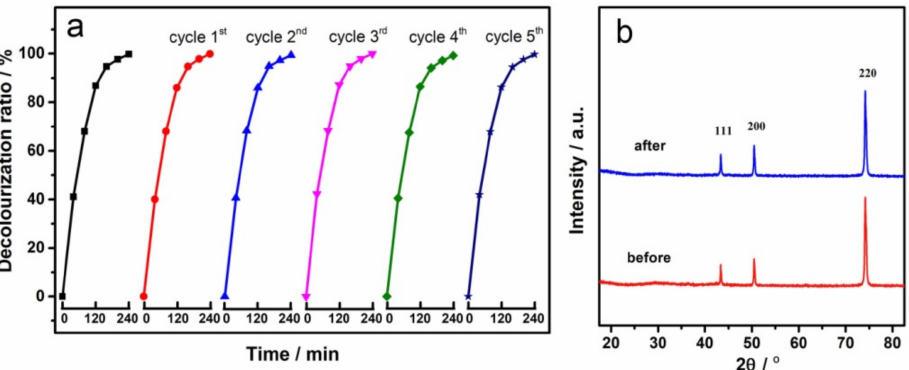
Figure 9. Cyclic performance of GCF-0.2 electrode ( a ) and XRD patterns before and after cycling ( b